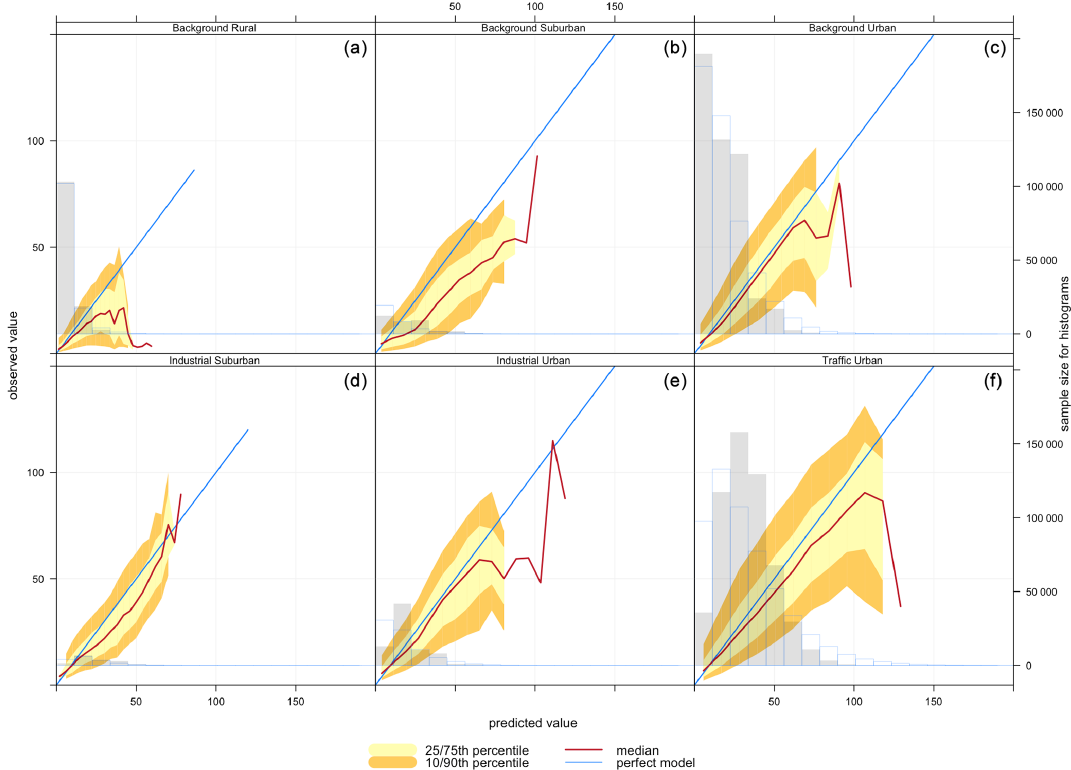
Figure 5. Conditional quantile plot of modelled and observed pollutant concentrations of NO 2 based on model 2 (CA + ENV) for all station environmental types: (a) background rural, (b) background suburban, (c) background urban, (d) industrial suburban, (e) industrial urban, and (f) traffic